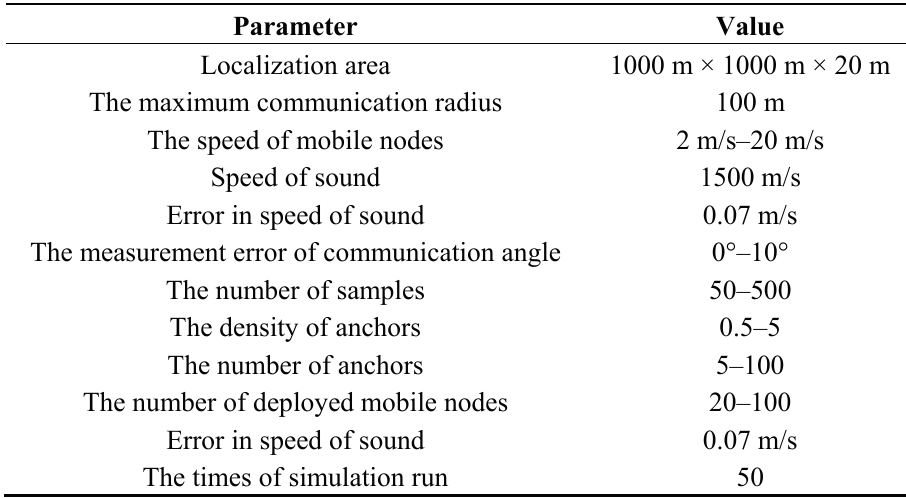
Table 3. Simulation